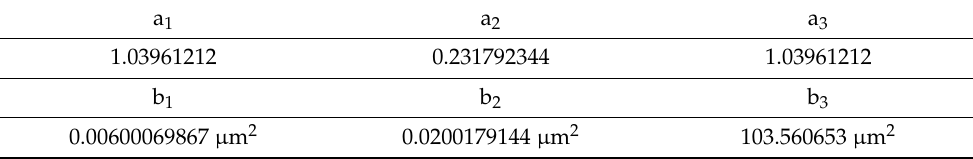
Table 1. As given in the Equation (1), the value of the constant’s